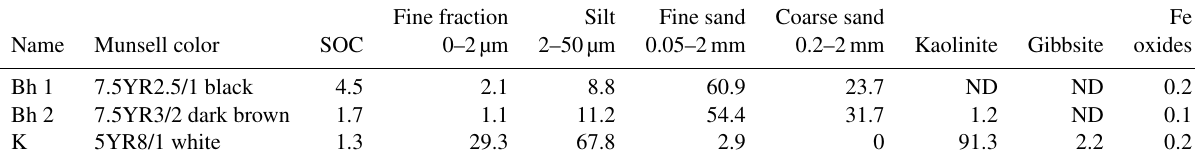
Table 2. Characteristics of the soil material used in the columns. Weight percent of bulk